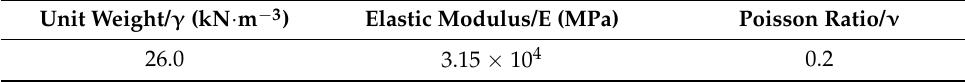
Table 2. Parameters of concrete material.